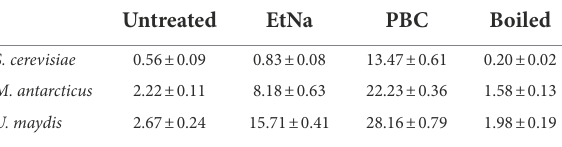
TABLE 4 The percentages (%) of particles falling into the “R1” area for different species-method combinations.